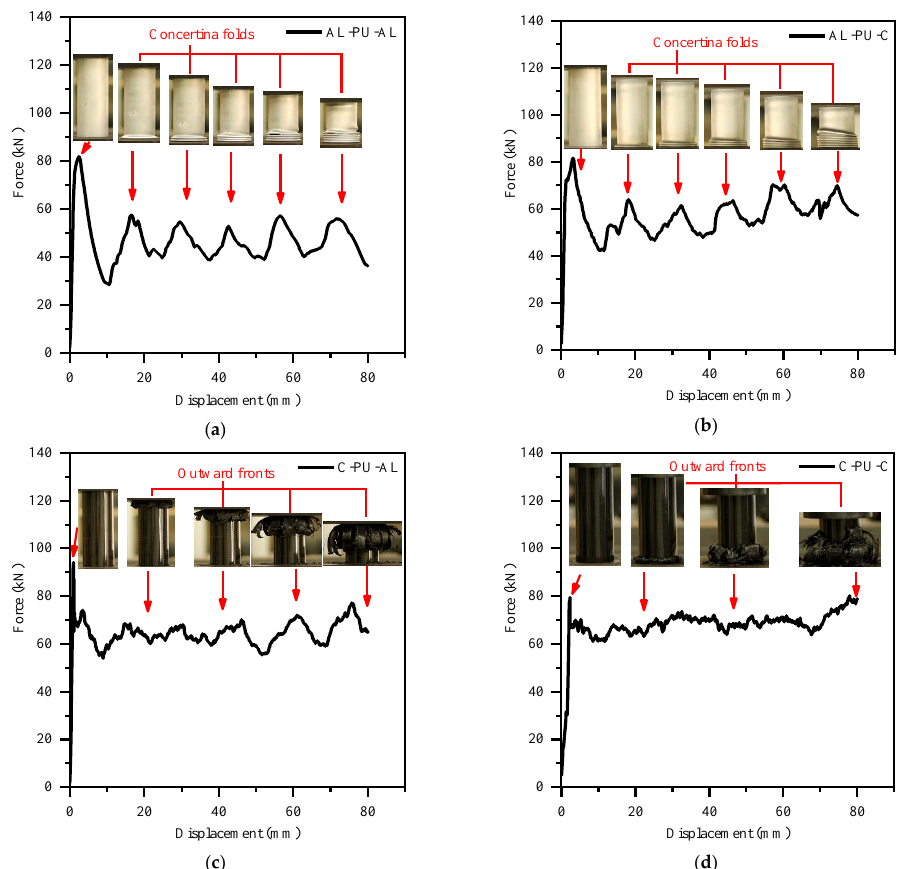
Figure 6. Deformation mode and force–displacement curves of hybrid structures: ( a ) AL-PU-AL; ( b ) AL-PU-C; ( c ) C-PU-AL; ( d )